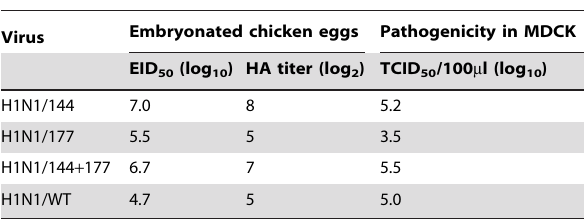
Table 3. In Vitro Characteristics of the Recombinant Viruses.